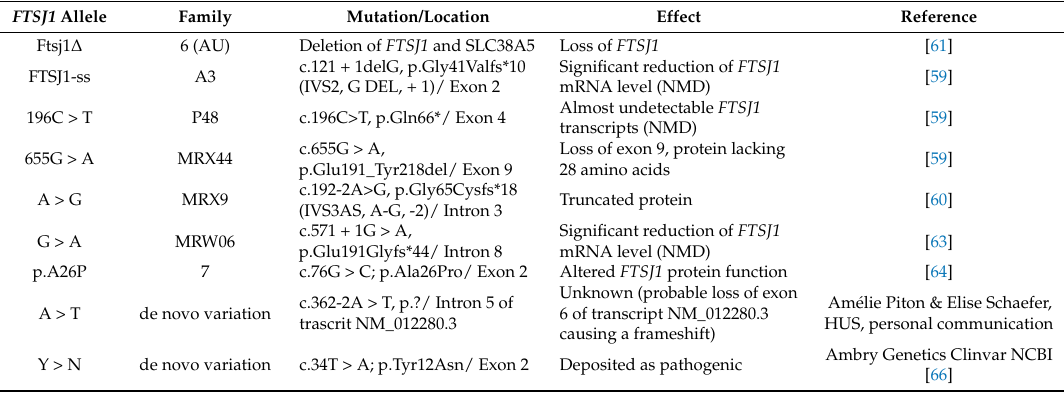
Table 1. FTSJ1 mutations associated with NSXLID (ss: splice site mutation, >: substitution, del: deletion, c.xxx: indicating the nucleotide (xxx) mutated on the gene coding DNA sequence (CDS), p.ZxY indicating that amino acid Z is changed by Y in the mutant and x indicates the AA position on the protein. HUS: H ô pitaux Universitaire de